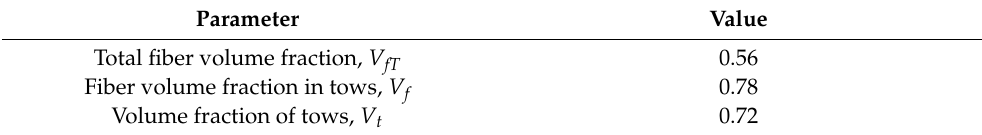
Table 4. Volume fraction parameters of the T300/Cycom970 plain-woven fabric composite.